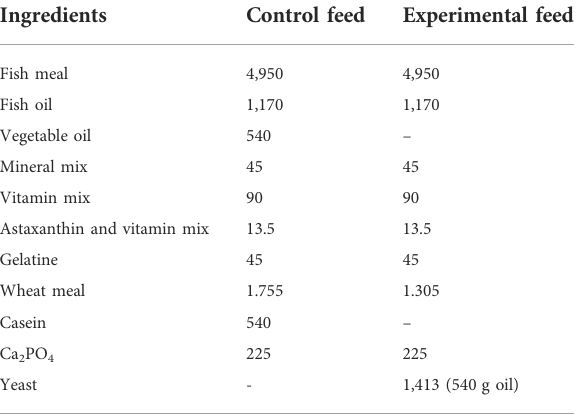
TABLE 1 Composition of control and experimentalyeast feeds (g kg − 1 ) for fi sh in duplicates. “ Vitamin mix ” and “ Mineral mix ”